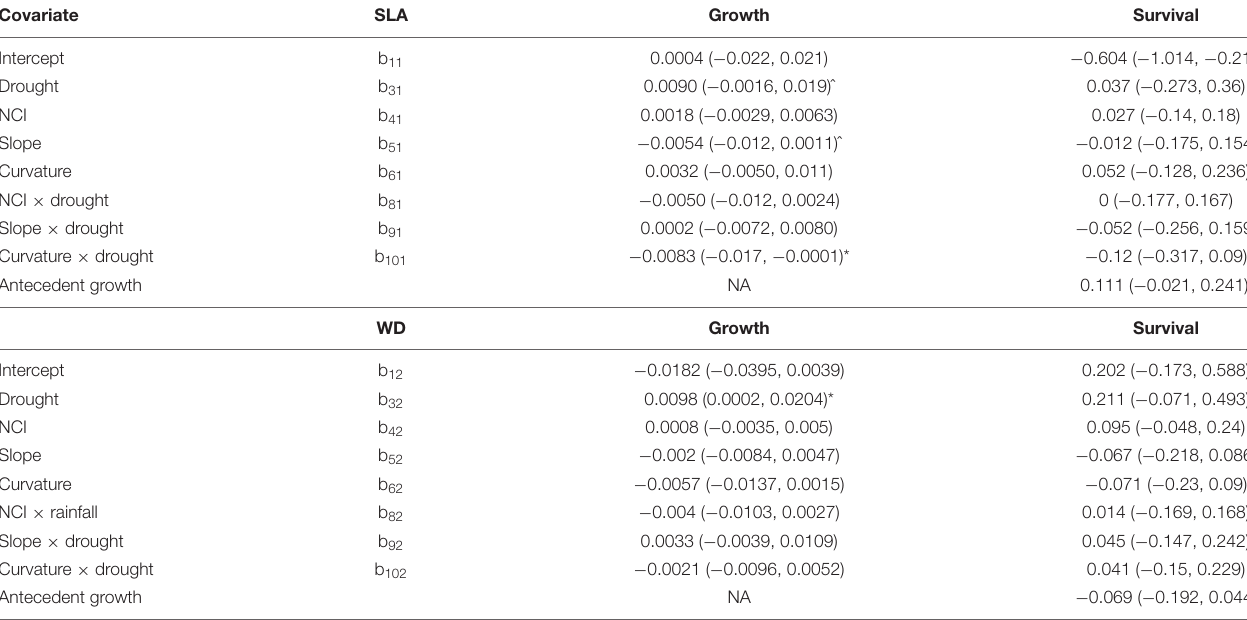
TABLE 2 | Parameters from the second level of the growth and survival models. Covariate SLA Growth